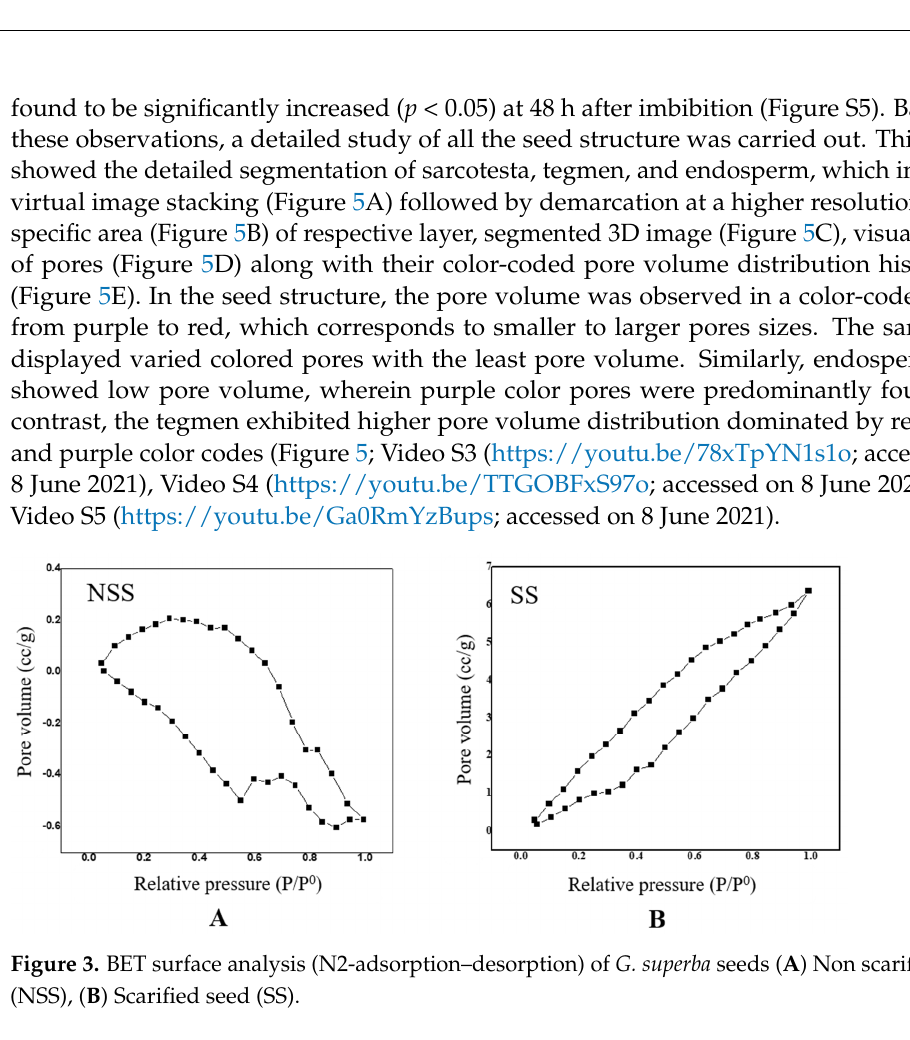
Figure 5. Detailed segmentation of pores in sarcotesta, tegmen, and endosperm; ( A ) Virtual image stack, ( B ) Demarcation, ( C ) Segmented 3D image, ( D ) Visualization of pores, ( E ) Color-coded pore volume distribution histogram; Colour scale- large (red) to small (purple). The overall porosity and pore network in the seed structures were also quantified. The porosity in sarcotesta and endosperm was the lowest and the connectivity among the pores was also negligible. Additionally, the tegmen showed 21% overall porosity, of which 17.5%